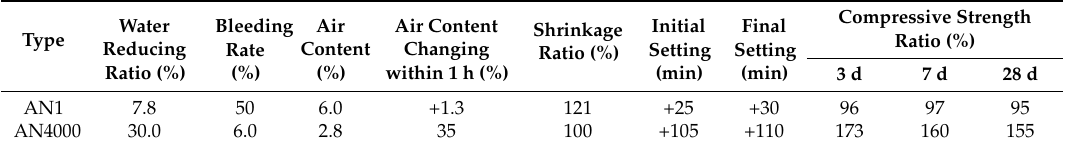
Table 4. Performance index summary for the AN4000 polycarboxylic water-reducer and the AN1 air entraining agent.